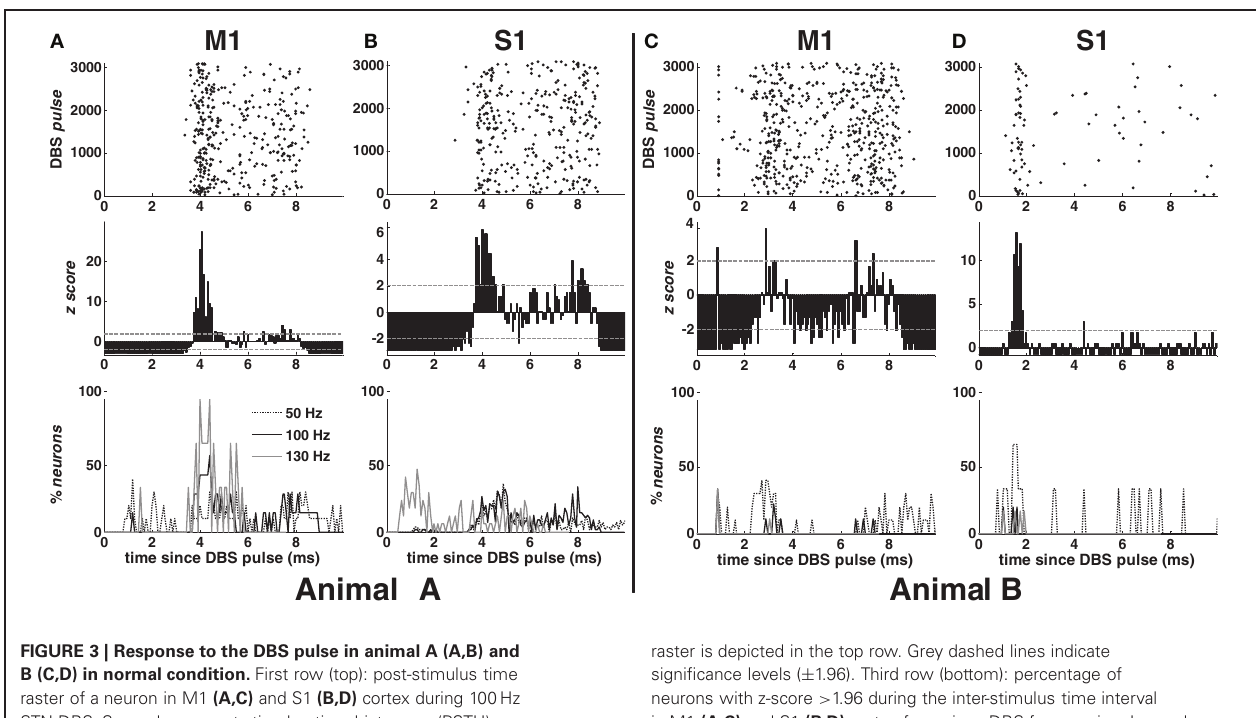
FIGURE 3 | Response to the DBS pulse in animal A (A,B) and B (C,D) in normal condition. First row (top): post-stimulus time raster of a neuron in M1 (A,C) and S1 (B,D) cortex during 100Hz STN DBS. Second row: post-stimulus time histogram (PSTH) normalized to the pre-DBS neuronal activity for the neurons whose